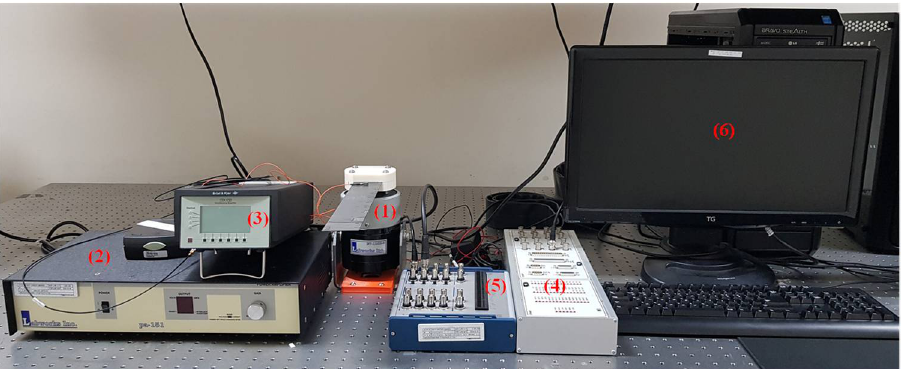
Figure 4. Various apparatus used in the experimental vibration testing; ( 1 ) shaker; ( 2 ) amplifier for the shaker; ( 3 ) amplifier for accelerometer; ( 4 ) DAQ1; ( 5 ) DAQ2; ( 6 ) Lab-view PC.